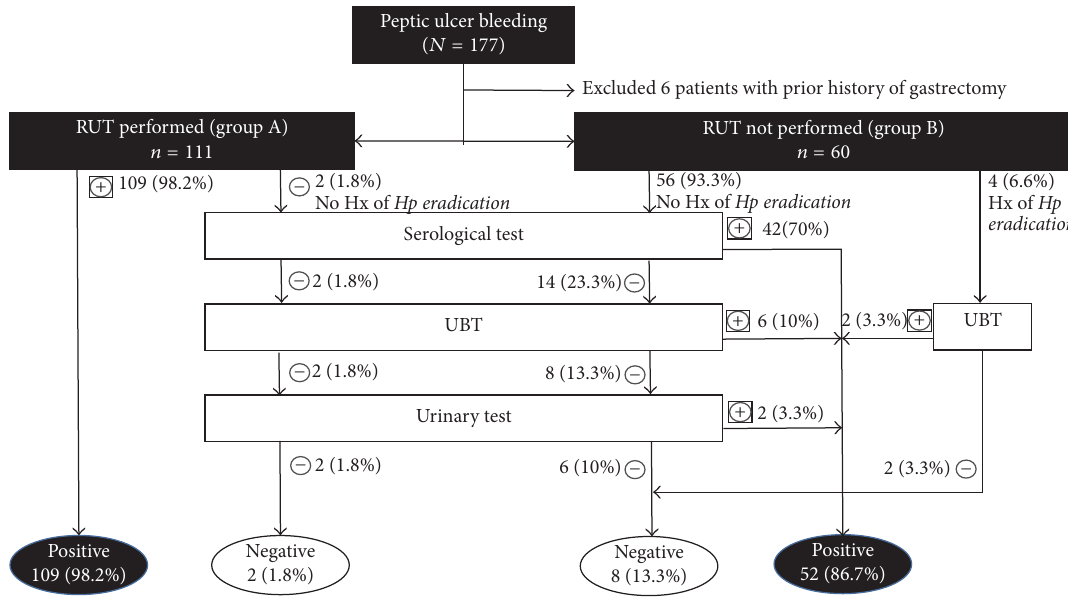
Figure 1: H. pylori testing in Vietnamese patients with acute peptic ulcer bleeding.